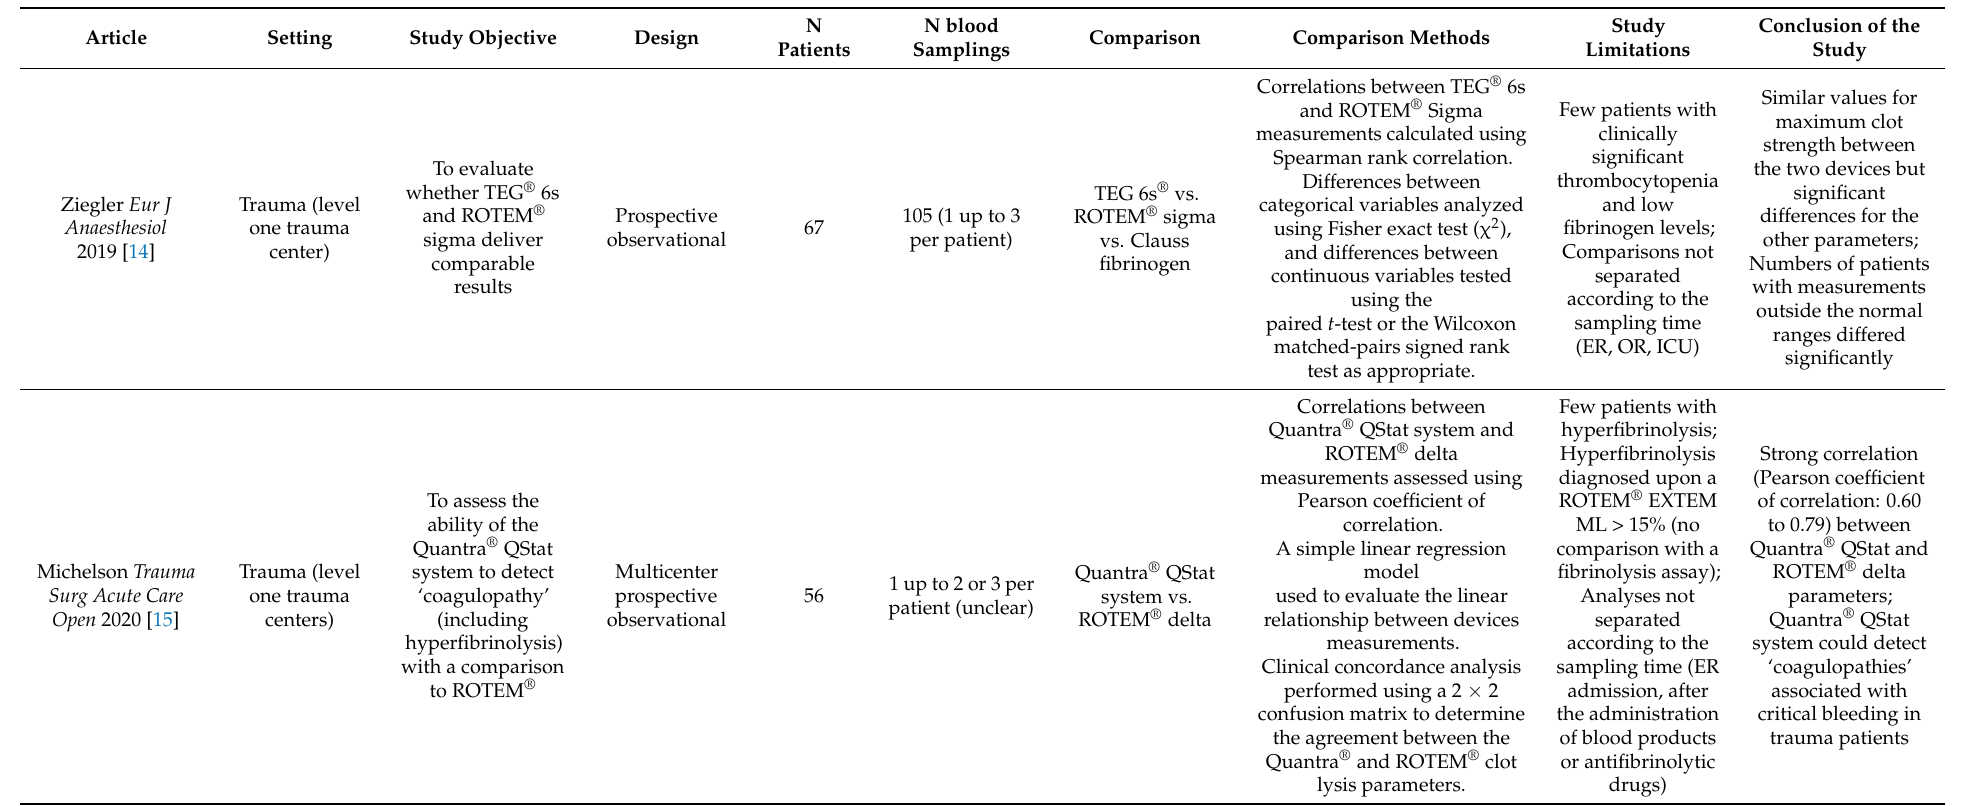
Table 1. Systematic short summary of retrieved studies comparing devices relying or not on the ‘cup and pin’ system, and new- and old-generation devices relying on the ‘cup and pin’